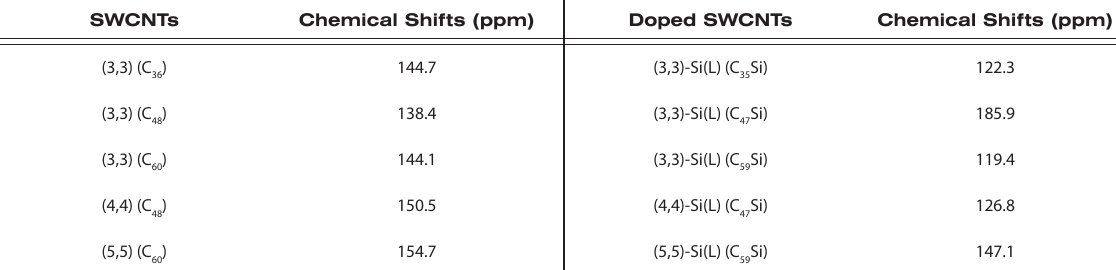
Table 3. The chemical shifts of the carbon atoms in the SWCNTs at B3LYP/6-31G(d) level